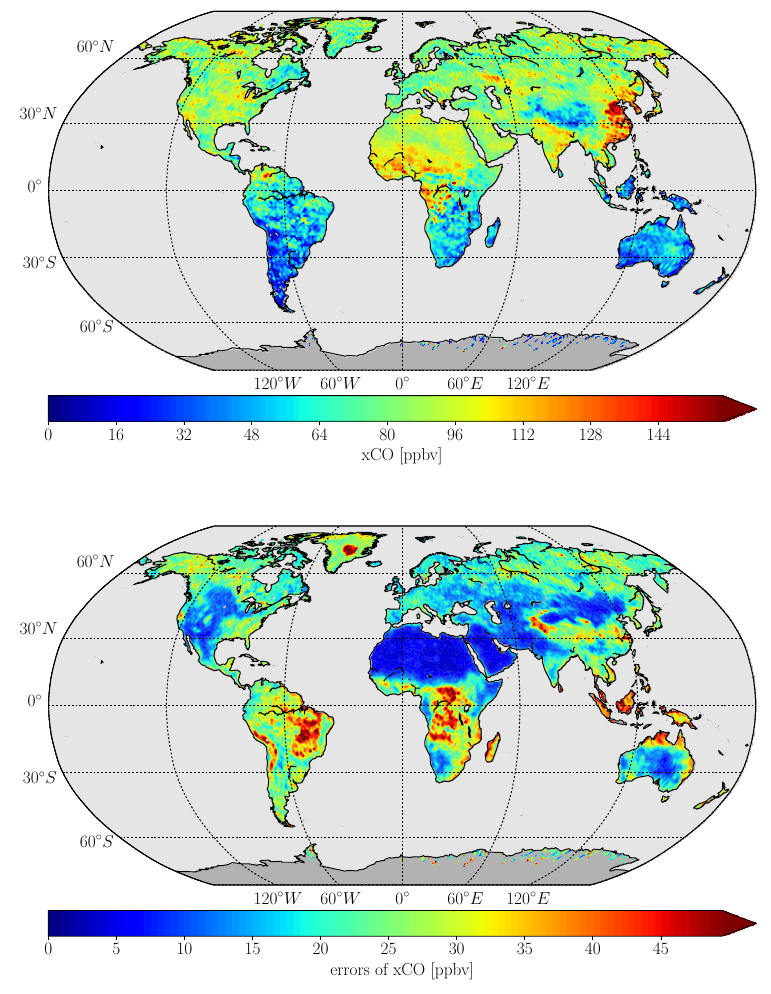
Figure A4. (Top) Global distribution of CO column-averaged dry-air mole fractions for the second quarter in 2004. (Bottom) The corresponding